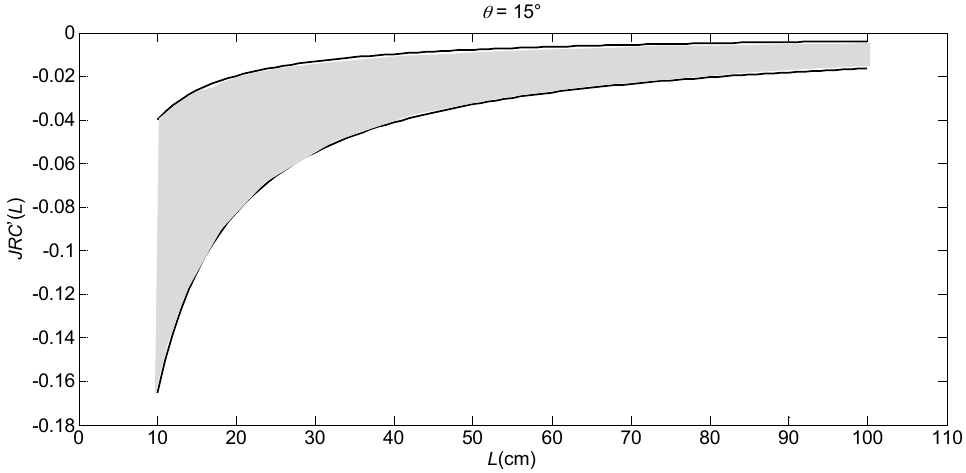
Figure 5. The changing rates of upper and lower limits of JRC ’( L ) in various sizes. Table 3. NN functions of JRC ( L ) for I ϵ [0, 0.5] corresponding to the JRC values of the joint samples in different orientations.